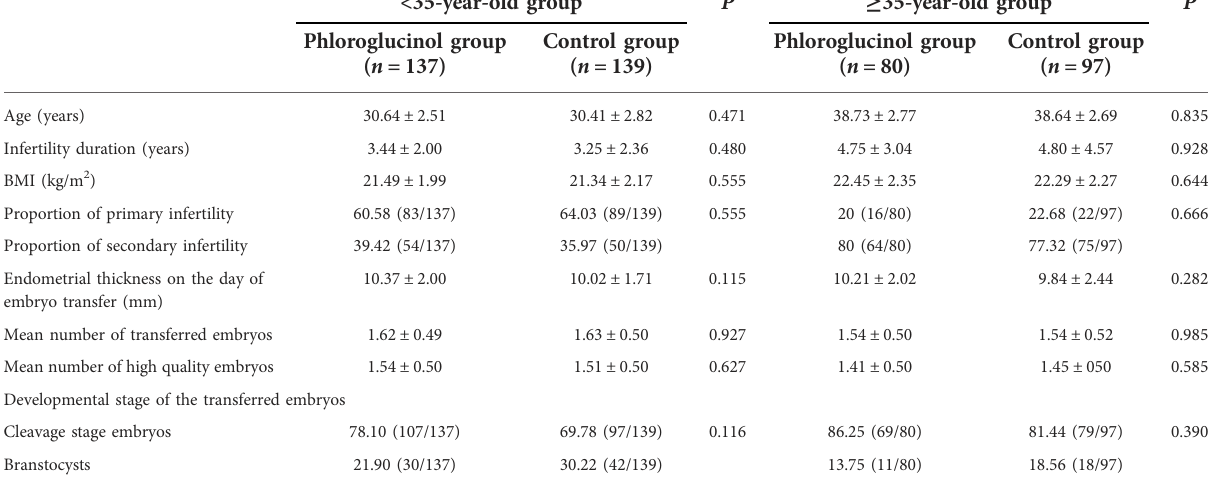
TABLE 3 Comparison between different Age groups of patients in terms of general information.